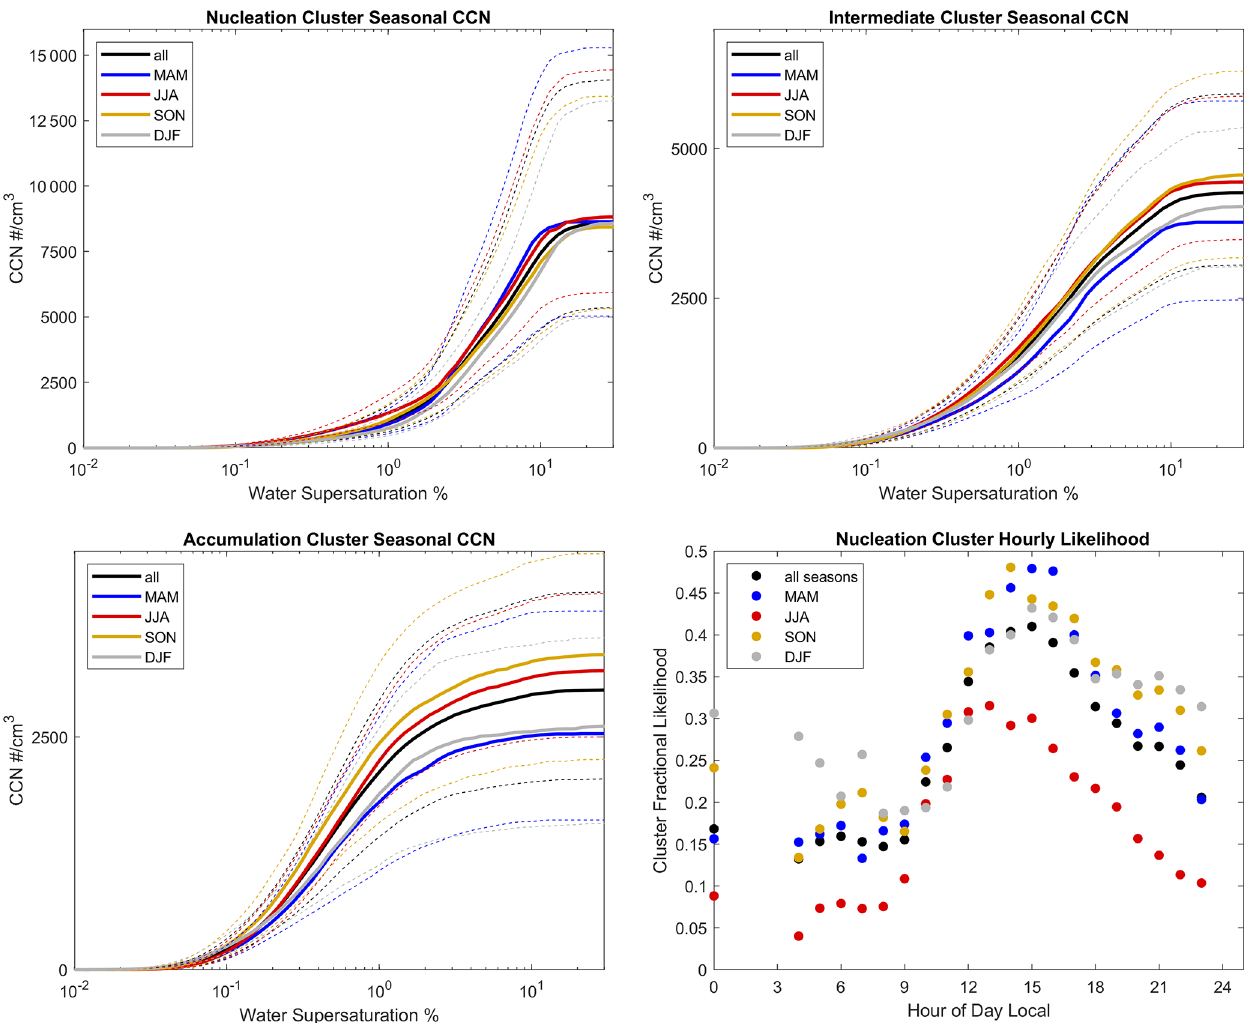
Figure C1. Median (solid lines) and confidence intervals containing 75% of the data (dotted lines) for each cluster as a function of the season, along with seasonal variations in hourly cluster likelihood for the nucleation mode cluster (bottom